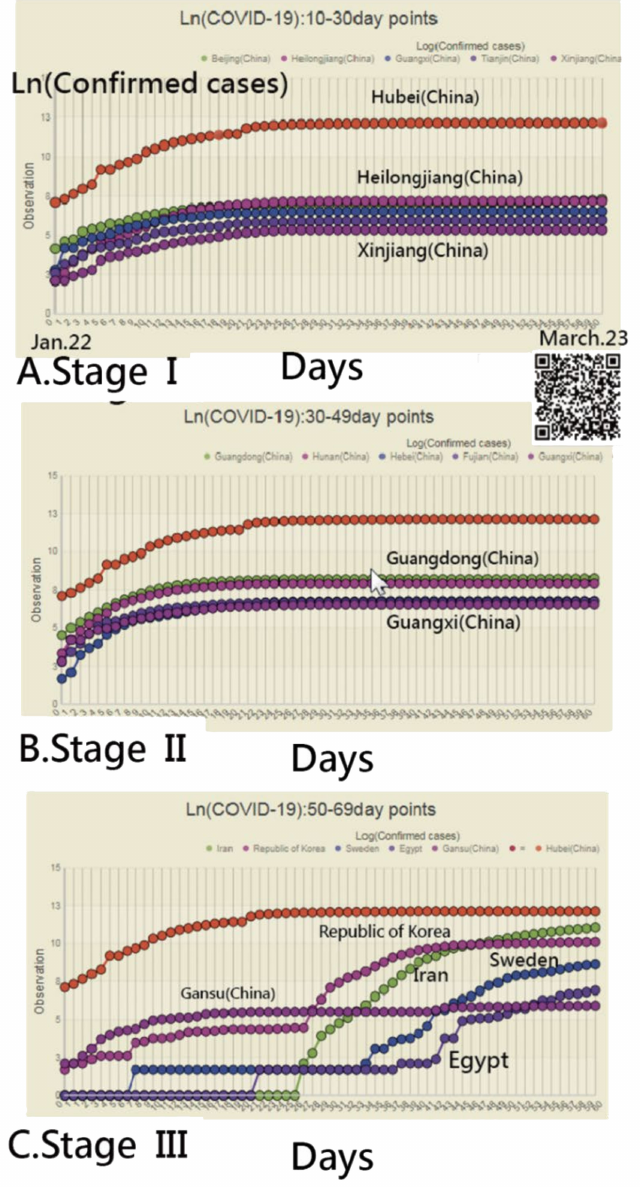
Figure 1. Matching the most similar regions using the correlation pattern across three clusters (stages) (Note: readers are invited to scan the QR-code to examine the detail on a